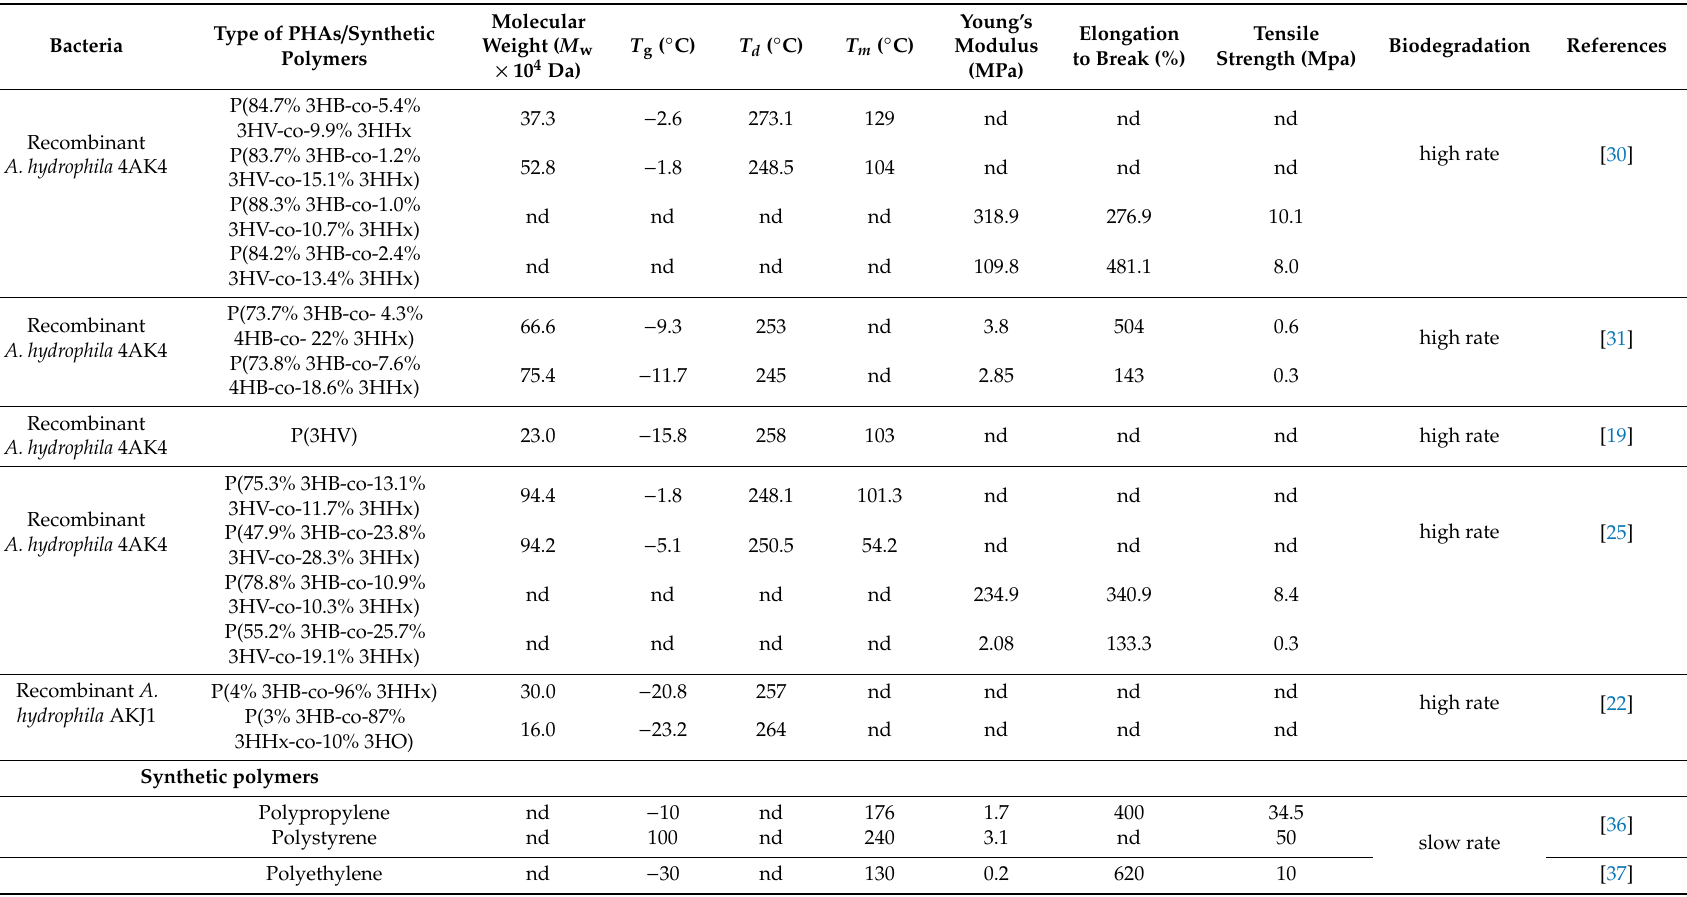
Table 3. Comparison of material properties of PHAs extracted from Aeromonas sp. cells and synthetic